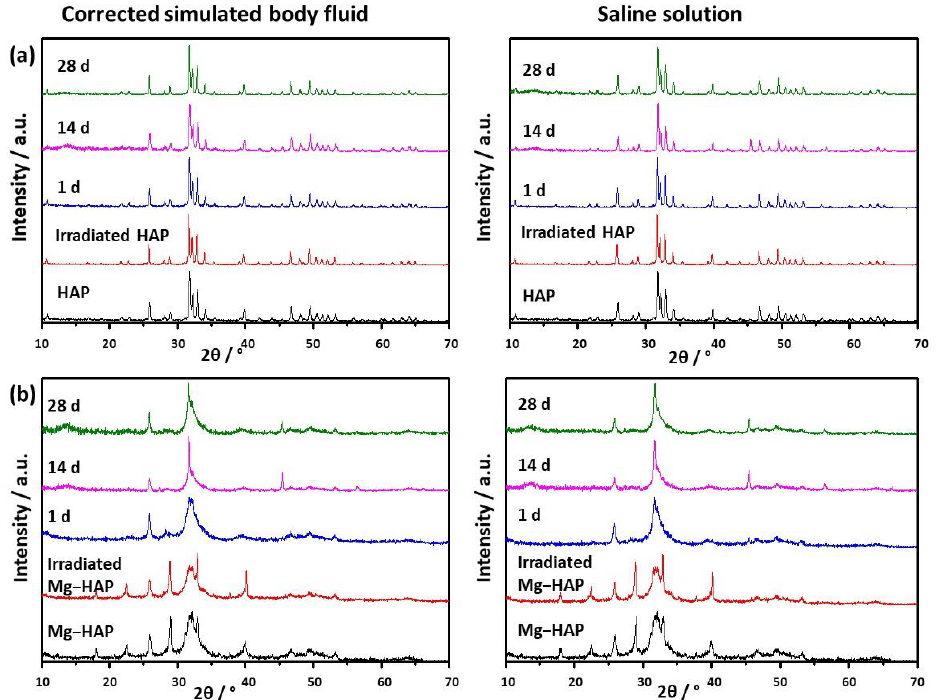
Figure 1. PXRD patterns of ( a ) non-substituted hydroxyapatite (HAP) and ( b ) Mg-substituted HAP (Mg-HAP) starting powder, powder irradiated to 25 kGy, and powders after immersion in corrected simulated body fluid (c-SBF) and saline solution (SS) for 1 – 28 days at 37 °C. The powder diffraction pattern of synthesized, non-doped HAP contains a number of sharp peaks, indicating good crystallinity (Figure 1a). The most prominent peaks were detected at 2 θ 10.86 ◦ , 25.91 ◦ , 31.81 ◦ , 32.25 ◦ and 32.95 ◦ corresponding to (100), (002), (211), (112) and (300) reflections of HAP (Table S1, JCPDS 09-0432). In the FTIR spectra (Figure 2a) vibrational bands of phosphate and hydroxy groups characteristic of HAP were observed (Table S2). The vibrations of phosphate groups were observed at 1087 cm − 1 and 1024 cm − 1 corresponding to ν 3a and ν 3c triply degenerate asymmetric stretching mode of P-O bonds, respectively; at 963 cm − 1 corresponding to ν 1 non-degenerate symmetric stretching mode of P-O bonds; at 599 cm − 1 and 564 cm − 1 corresponding to ν 4a and ν 4c triply degenerate bending mode of O-P-O bonds, respectively; and at 474 cm − 1 corresponding to ν 2a double degenerate bending mode of O-P-O bonds [33]. Two bands characteristic of vibration of